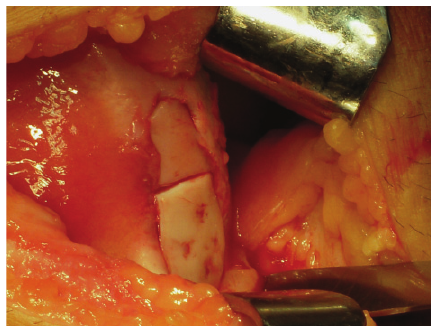
Figure 3: The same lesion after reduction and fixation of the two osteochondral fragments with five bioabsorbable pins.